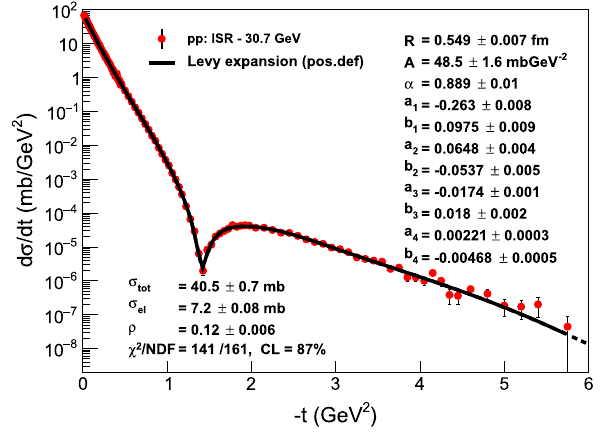
Fig. 21 Fourth-order Lévy expansion fits of the differential cross- section data from Ref. [45] on pp elastic scattering at GeV